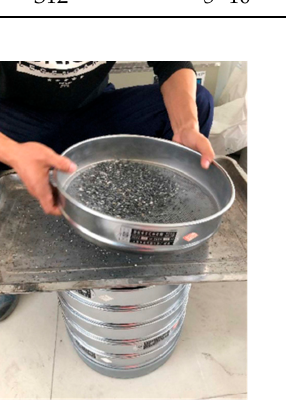
Figure 2. Aggregate and limestone powder screening. Table 2. Test results of technical indicators of coarse aggregate.